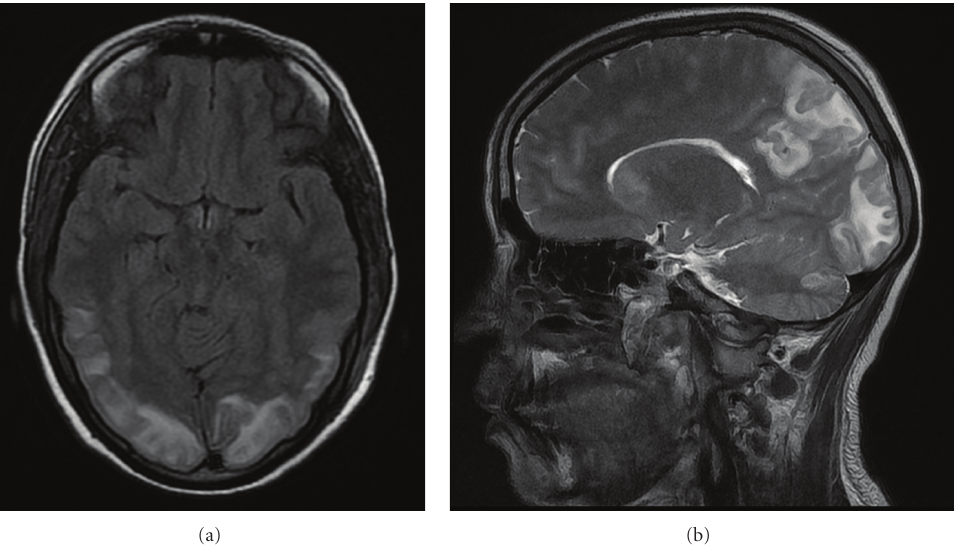
Figure 1: The patient MRI findings in postoperative first